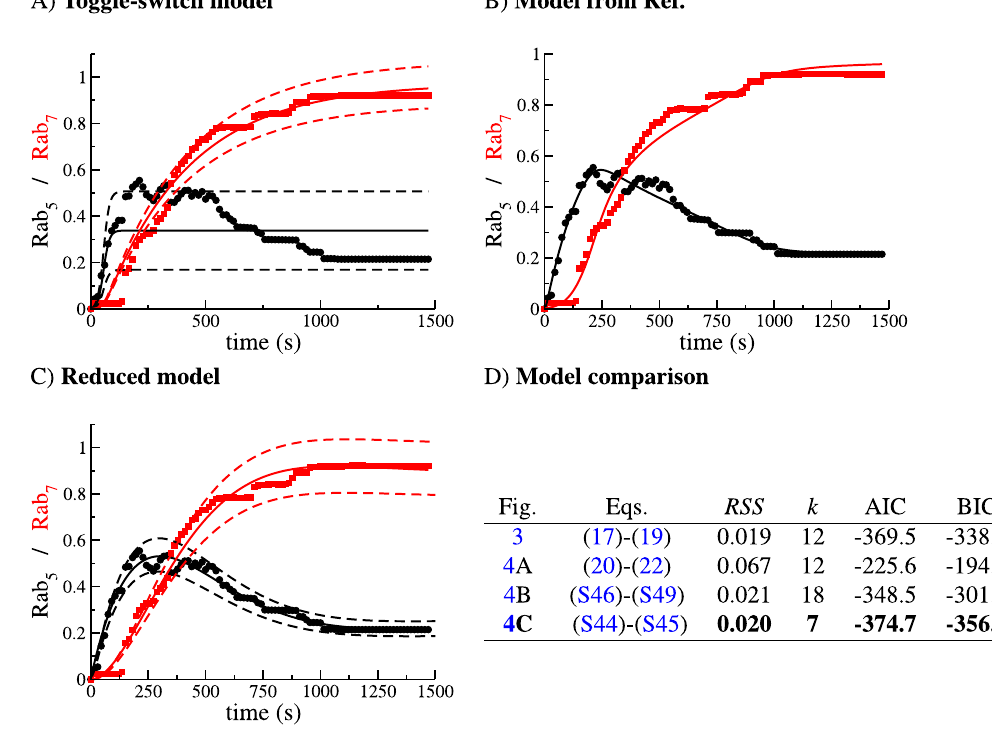
Figure 4. Cut-off switch model (and its reduced version) explains the data more parsimoniously. ( A ) Toggle-switch model, Eqs. (20)–(22). ( B ) Model from Ref. 21 (see also Eqs. (S46)–(S49) in the Supplementary Information). ( C ) Comparison of the sensitivity-based reduced model, Eqs. (S44)–(S45) (see Supplementary Information for details). ( D ) Model comparison based on the Akaike Information Criterion, Eq. (24) and the Bayesian Information Criterion, Eq. (25). The selected model according to the minimum AIC and BIC is the one shown in boldface. Dashed lines represent the mean ± the standard deviation, as described by Eqs.